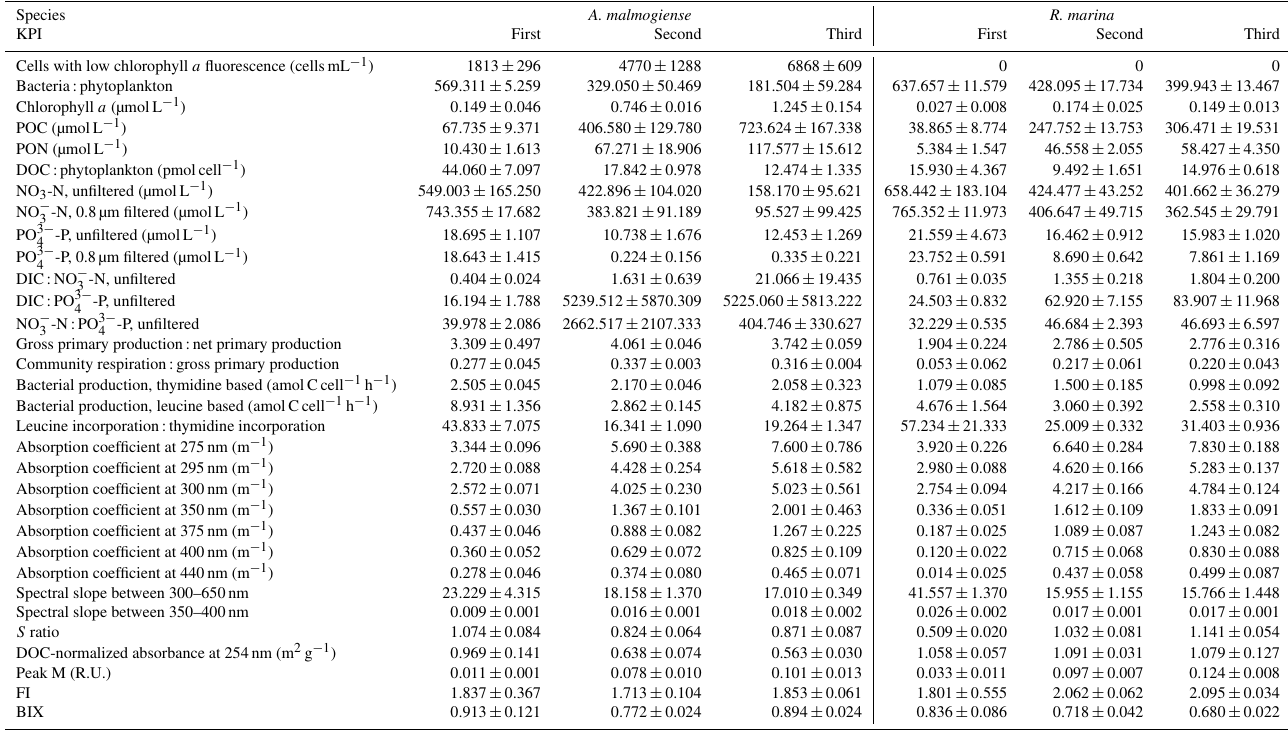
Table A1. Mean ± 1SD of additional variables at each KPI in the DOM release experiment. S ratio: ratio of spectral slopes between 275–295 and 350–400nm (Helms et al., 2008). Peak M: marine humic-like DOM (Coble, 1996). FI: fluorescence index (Mcknight et al., 2001). BIX: biological index (Huguet et al.,